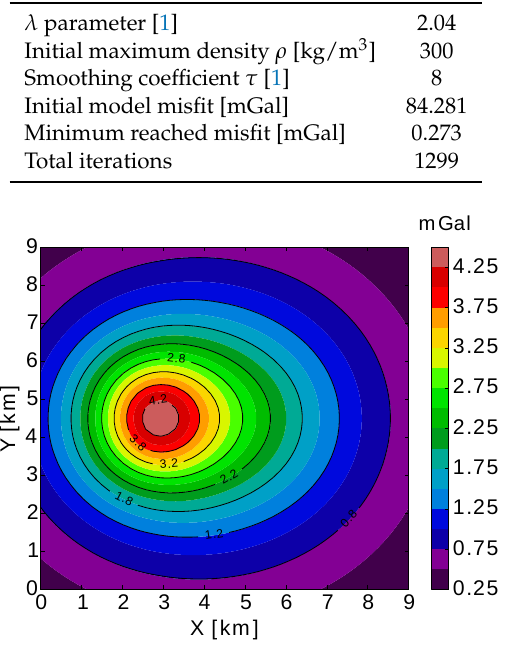
Figure 19. Initial (colour map) and inverted (contour lines) gravimetric ( G z ) response for the S